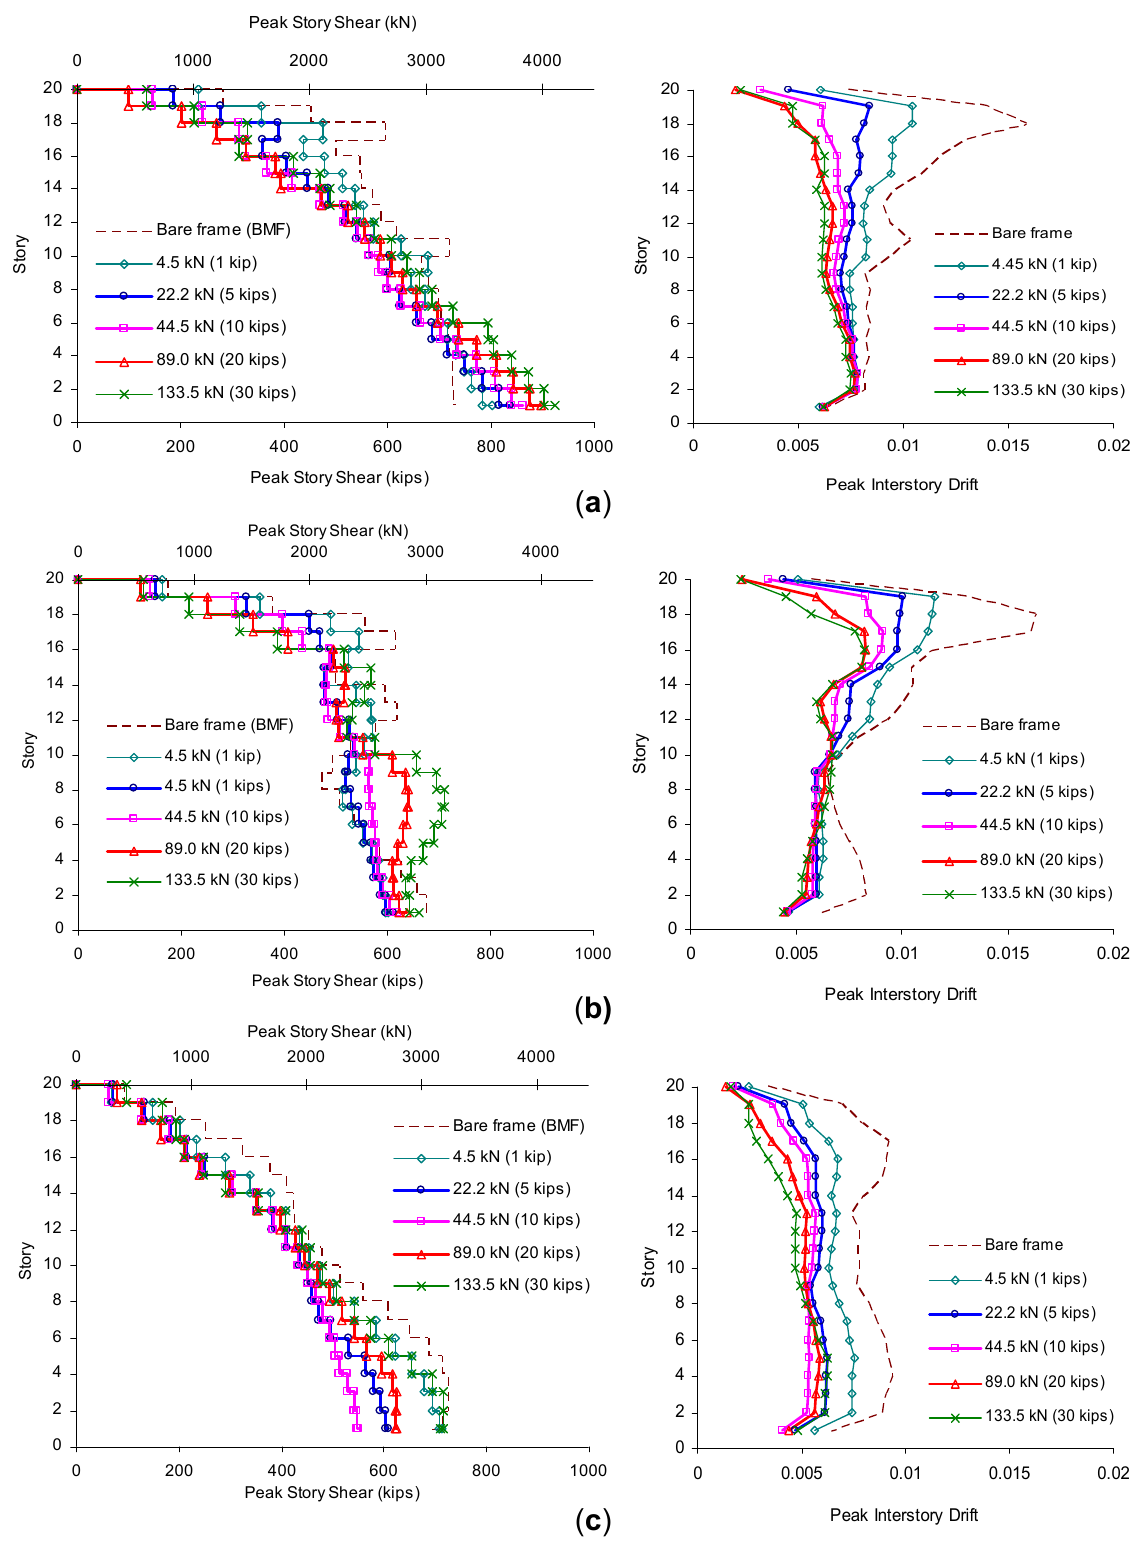
Figure 10. Effect of slip loads story shear and interstory drift. ( a ) Under LOMAP1; ( b ) Under LOMAP2; ( c ) Under LOMAP3. Peak Story Shear